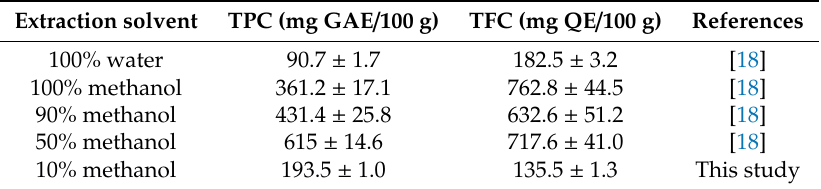
Table 1. Total phenolic and total flavonoid content in the E. elatior extract extracted using di ff erent percentages of methanol in the extraction